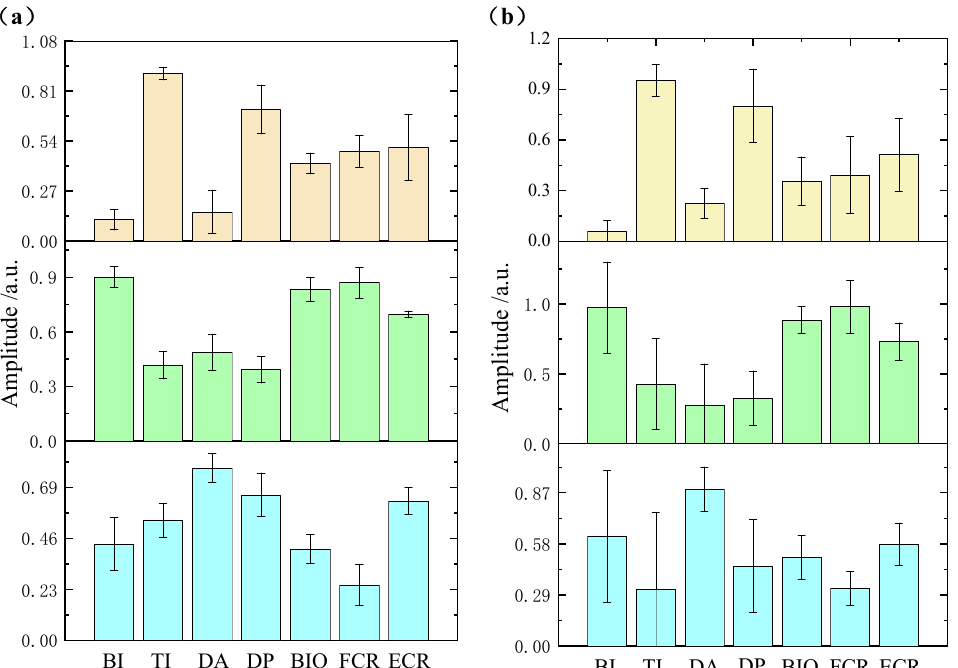
Figure 6. The statistical chart of synergies extracted by MCR-ALS ( a ) and NMF ( b ) from a typical healthy subject.